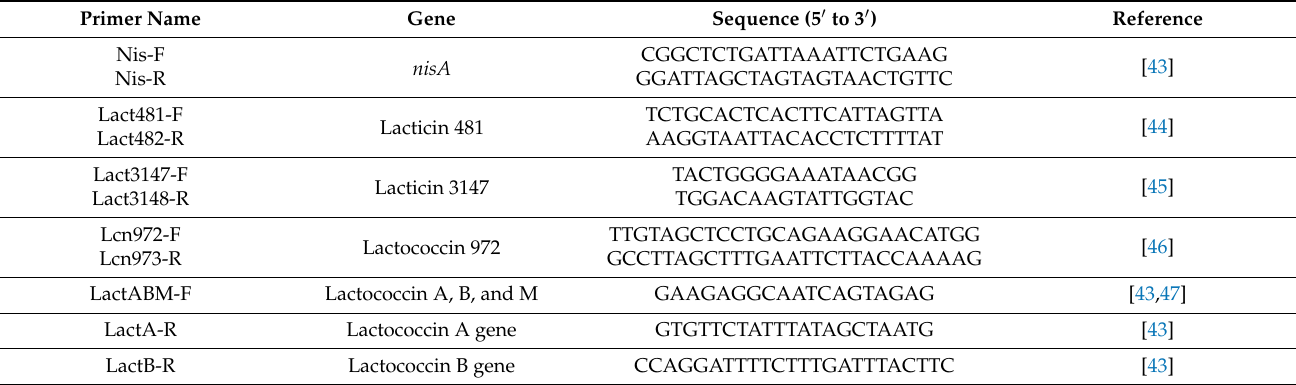
Table 3. PCR primers used to detect common bacteriocins produced by L . lactis strains and nisin biosynthesis-related genes. Primer